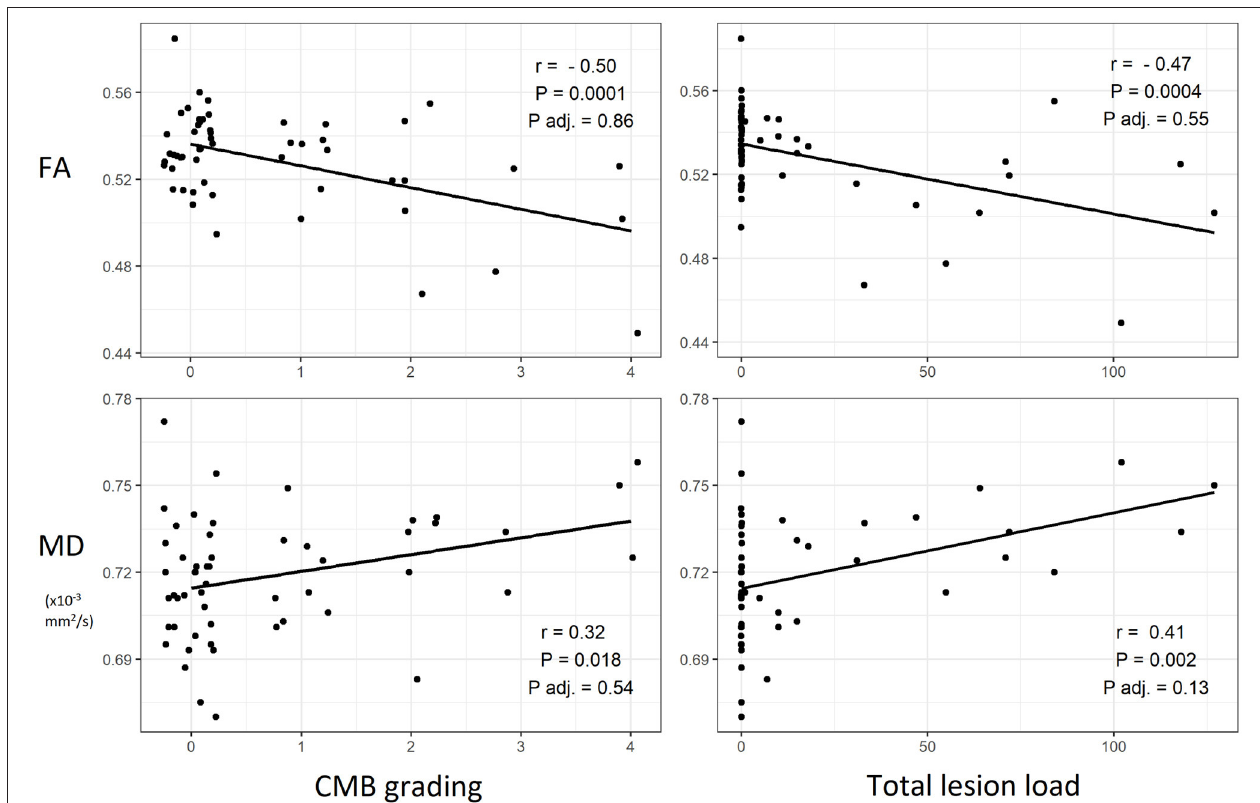
FIGURE 4 | Scatterplots of cerebral microbleeds (CMB) and white matter microstructural properties with best fit lines and corresponding Pearson’s correlation coefficients and P -values. An additional P -value ( P adj.) for a linear model adjusted for clinical severity of traumatic brain injury (Glasgow Coma Scale and length of post-traumatic amnesia) is shown. FA, fractional anisotropy, MD, mean